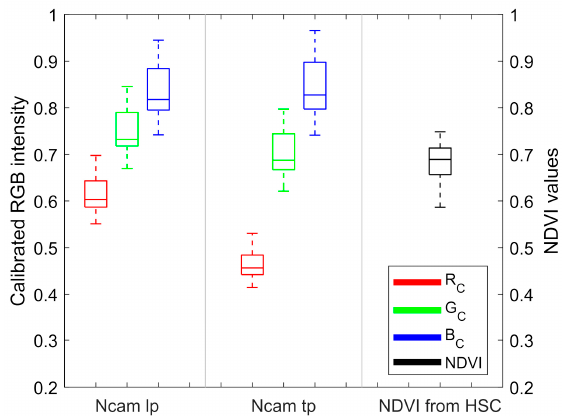
Figure 4. The boxplot of the corn plants raw dataset from Ncams and HSC after calibration with the whiteboard.